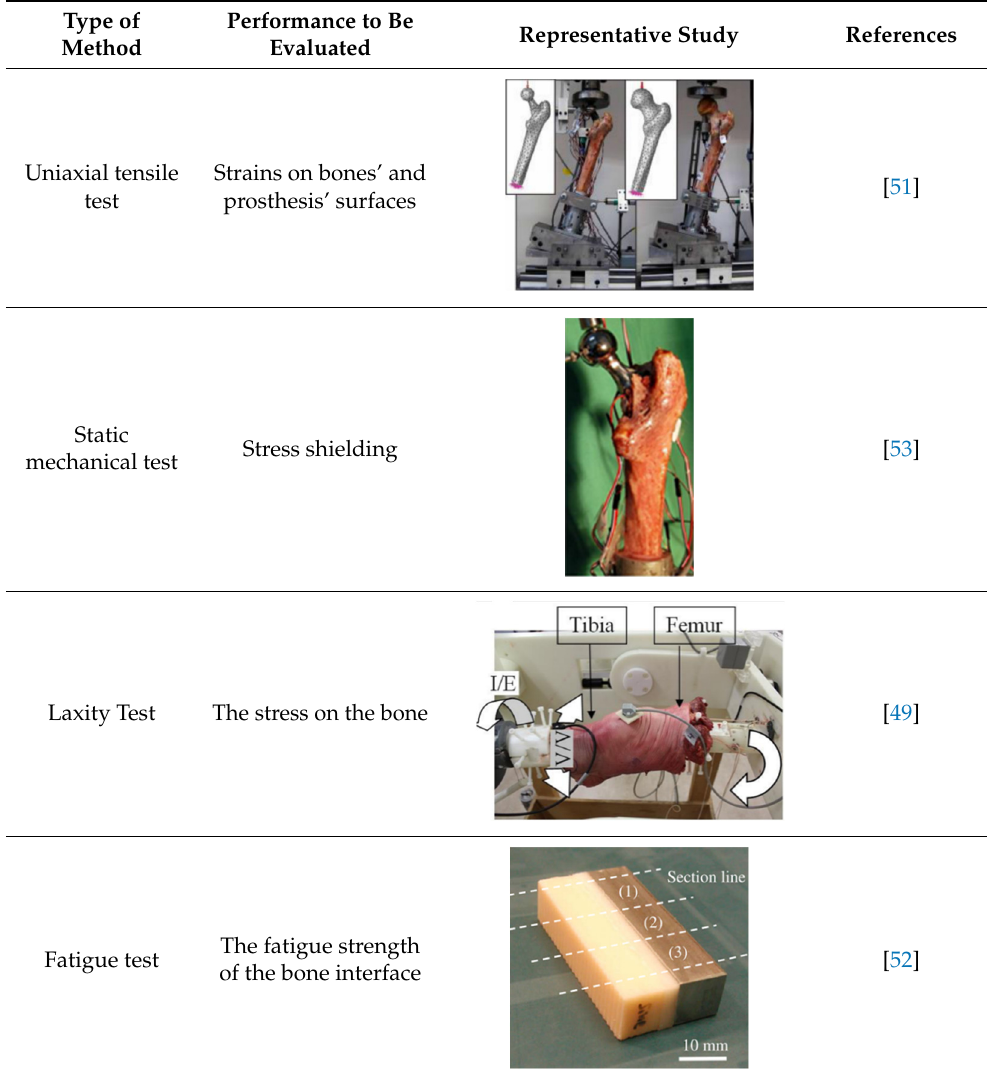
Table 7. The widely used in vitro testing methods for evaluating the performance of bone joint replacements.